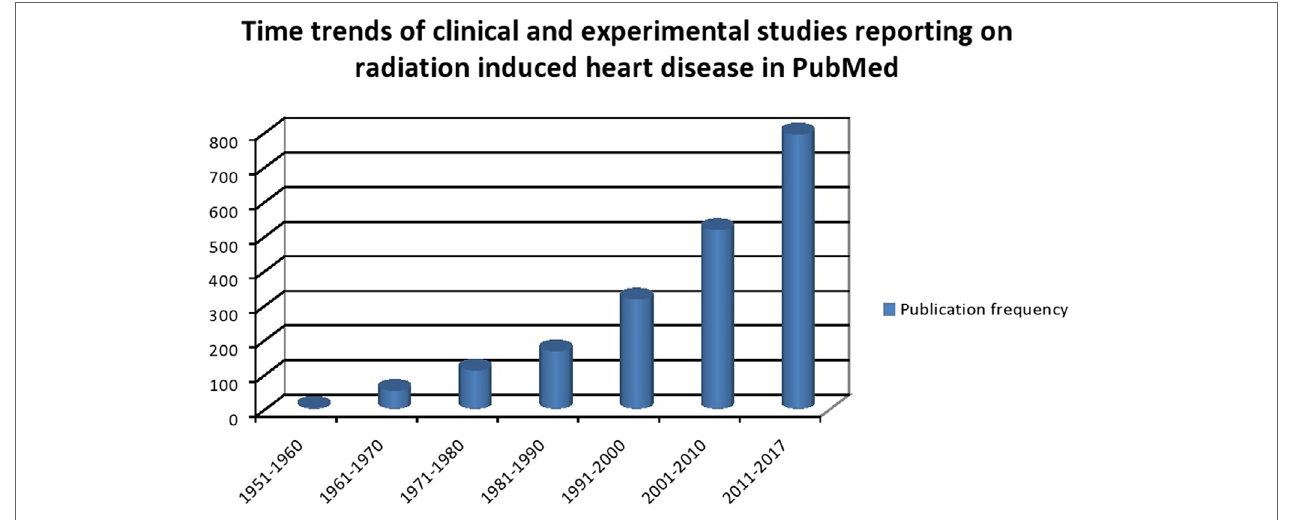
FigURe 1 | Time trends of clinical and experimental studies reporting on radiation-induced heart disease in